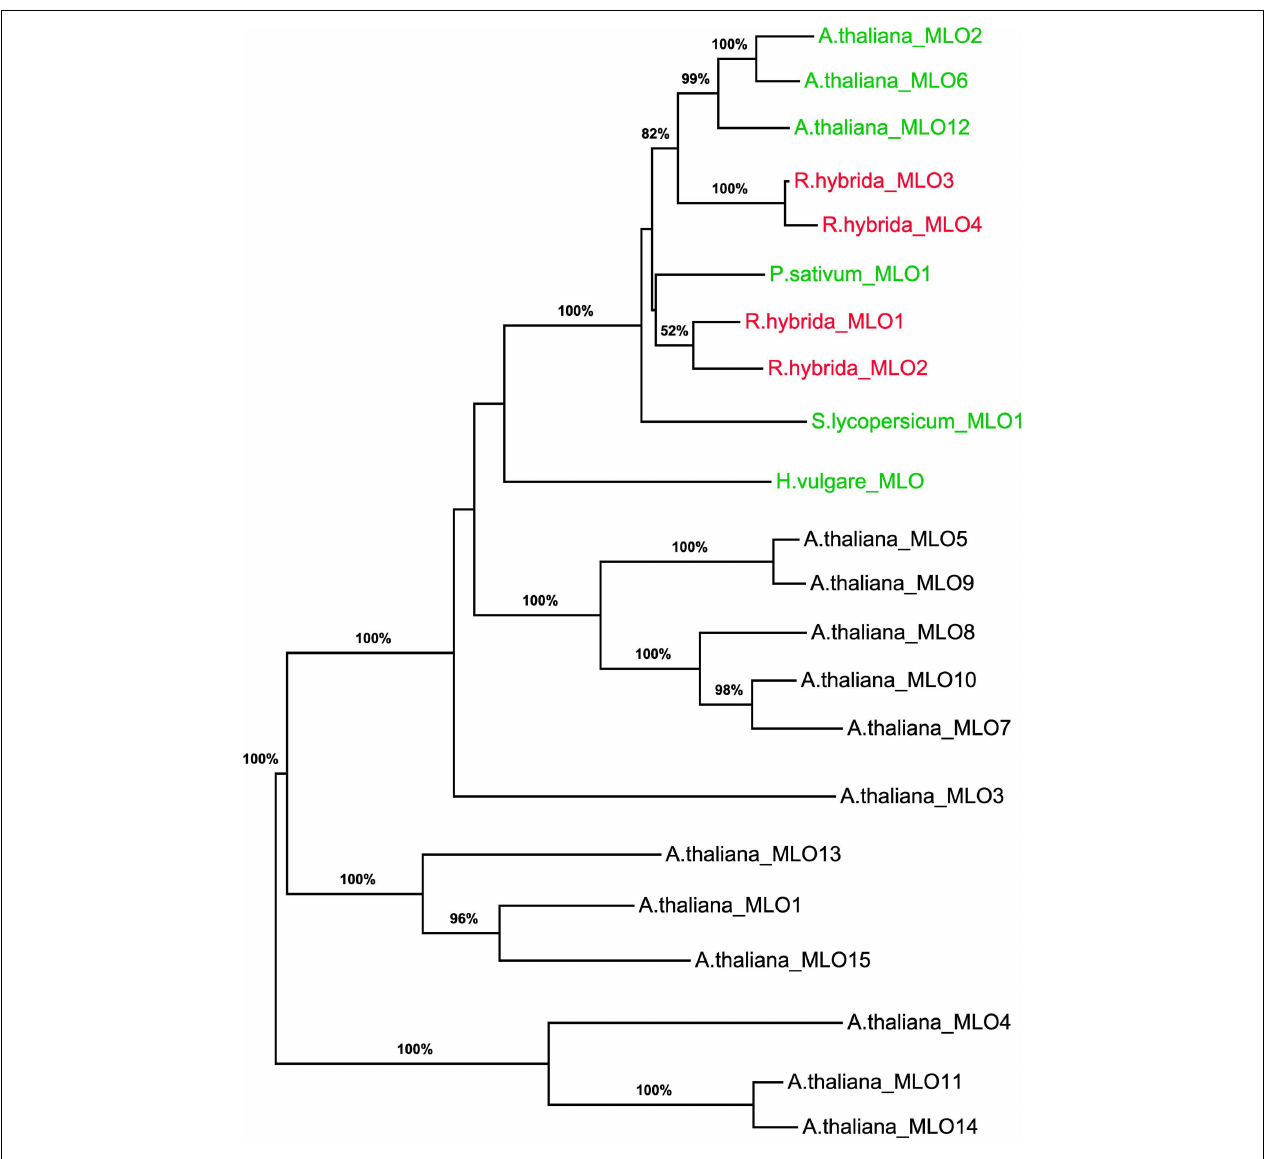
containing the MLO orthologs involved in plant powdery mildew interactions are indicated by colored gene names.The names of the rose MLO sequences are printed in red. GenBank Accession numbers of the MLO genes encoding the respective proteins are as follows: RhMLO1–4 (JX847131–JX847134), HvMLO (Z83834), AtMLO1 (Z95352), AtMLO2–AtMLO15 (AF369563–AF369576), PsMLO1 (FJ463618), SlMLO1